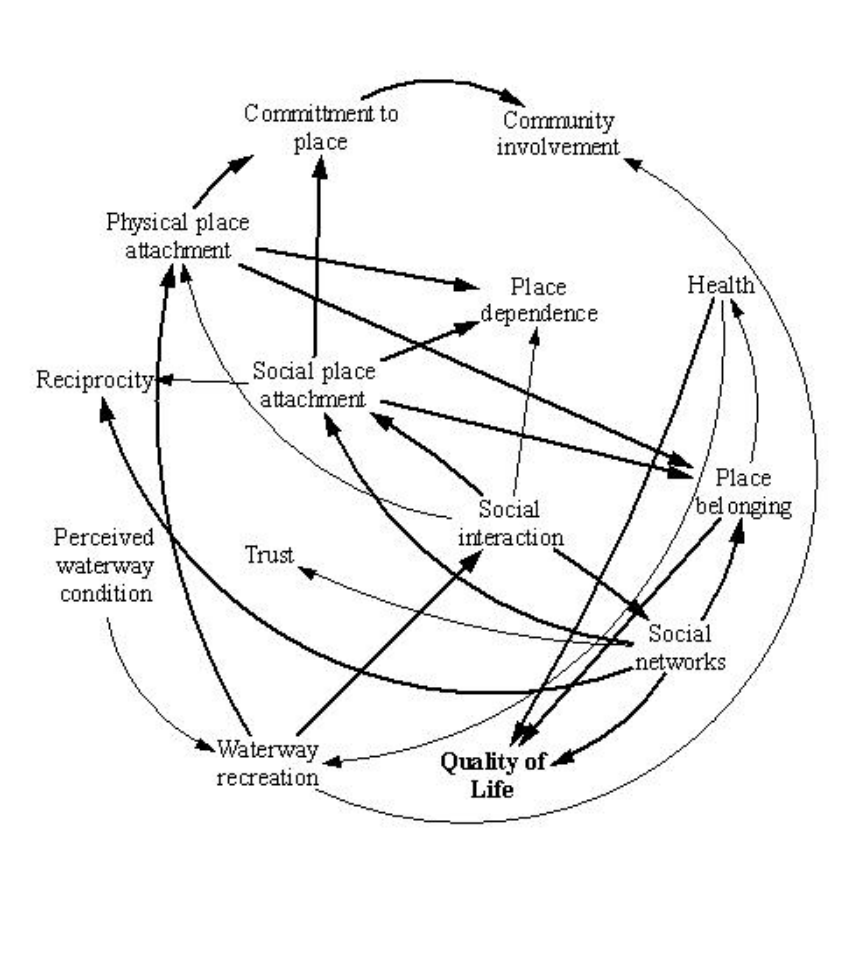
Fig. 3. Significant paths between perceived waterway condition and quality of life in the Pumicestone region. Paths in bold are common to both study